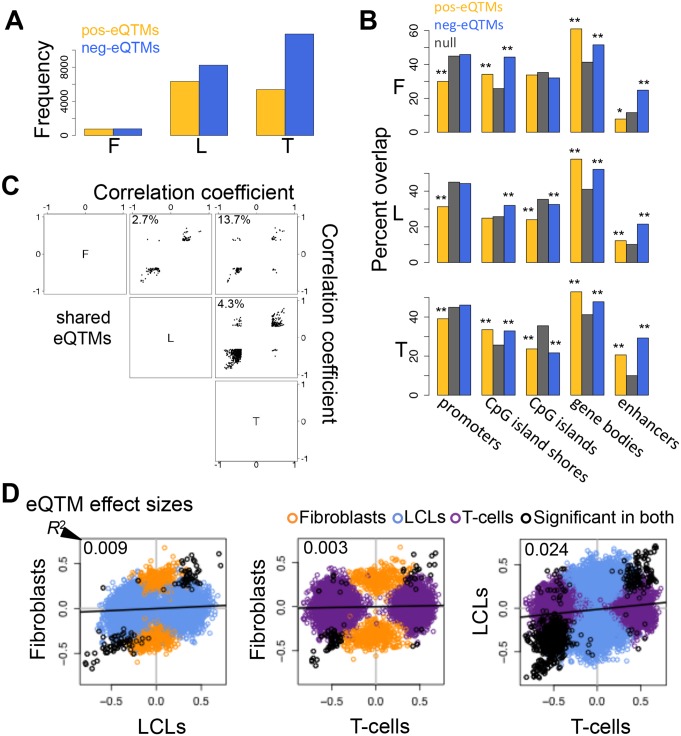
Properties of DNA methylation when associated to gene expression.(A) Number of all significant positive (pos-eQTMs) and negative (neg-eQTMs) correlations between DNA methylation and gene expression in fibroblasts (F), LCLs (L) and T-cells (T). A larger number of neg-eQTMs is found in all three cell-types, but an important part is composed of pos-eQTMs. (B) Percent of pos-eQTMs, neg-eQTMs and null sites that overlap with promoters, CpG island shores, CpG islands, gene bodies and enhancers. Pos-eQTMs are significantly depleted in promoter proximal regions in all cell-types. In most cases both positive and negative eQTMs are enriched for CpG island shores, gene bodies and enhancers, and depleted for CpG islands. One star indicates P < 0.05, two stars indicate P < 5E-04, Fisher’s exact test. (C) Correlation coefficients of eQTMs significant in both cell-types compared for all pair wise combinations of the three cell-types are plotted. The percentage of discordant cases (associations with opposite sign between any pair of cell-types) is indicated in the top left corner of each panel. Most eQTMs that are significant in any pair of cell-types have the same sign of association. (D) eQTM effect sizes are measured as the slope of the linear regression of expression given methylation on scaled values, and compared between cell-types for union of eQTMs. Black dots are significant eQTMs (same CpG-exon pair) in both the cell-types compared; orange, blue and purple dots are eQTMs significant only in fibroblast, LCL and T-cell, respectively, within the pair compared. Coefficient of determination R
2, reflecting the proportion of effect size variance in one cell-type explained by the other cell-type, is shown in the top left corner of each plot (S1 Table). This shows that there is a large amount of tissue-specific effects for correlations between DNA methylation and gene expression.